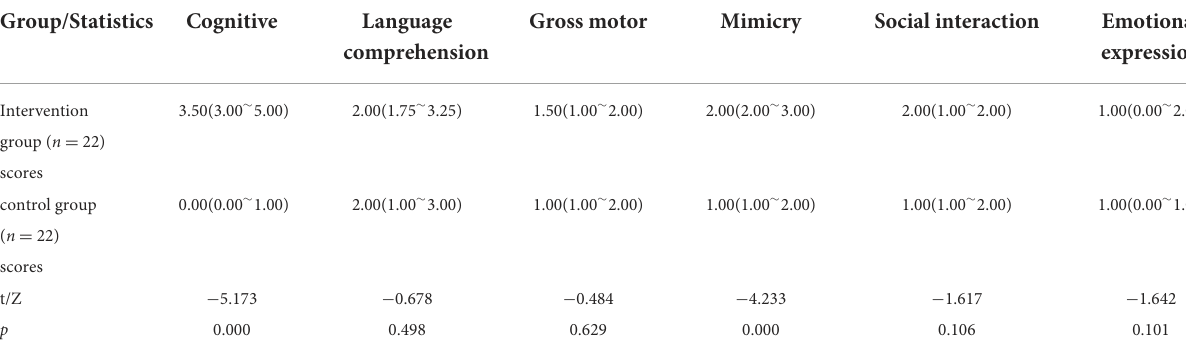
TABLE 4 Score comparison of the two groups before and after intervention. Group/Statistics